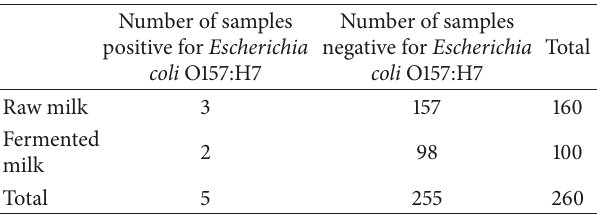
Table 3: Frequency of Escherichia coli O157:H7 isolates from raw and fermented milk samples.